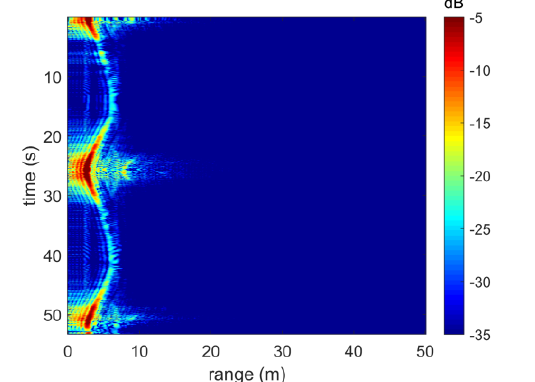
Figure 6. Range-Time image of moving target in front of the radar